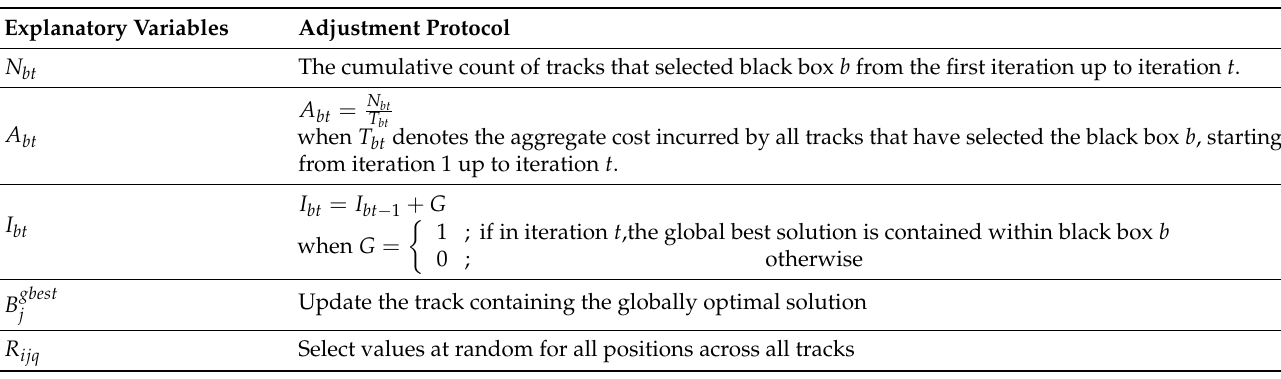
Table 3. Enumerated set of variables requiring iterative